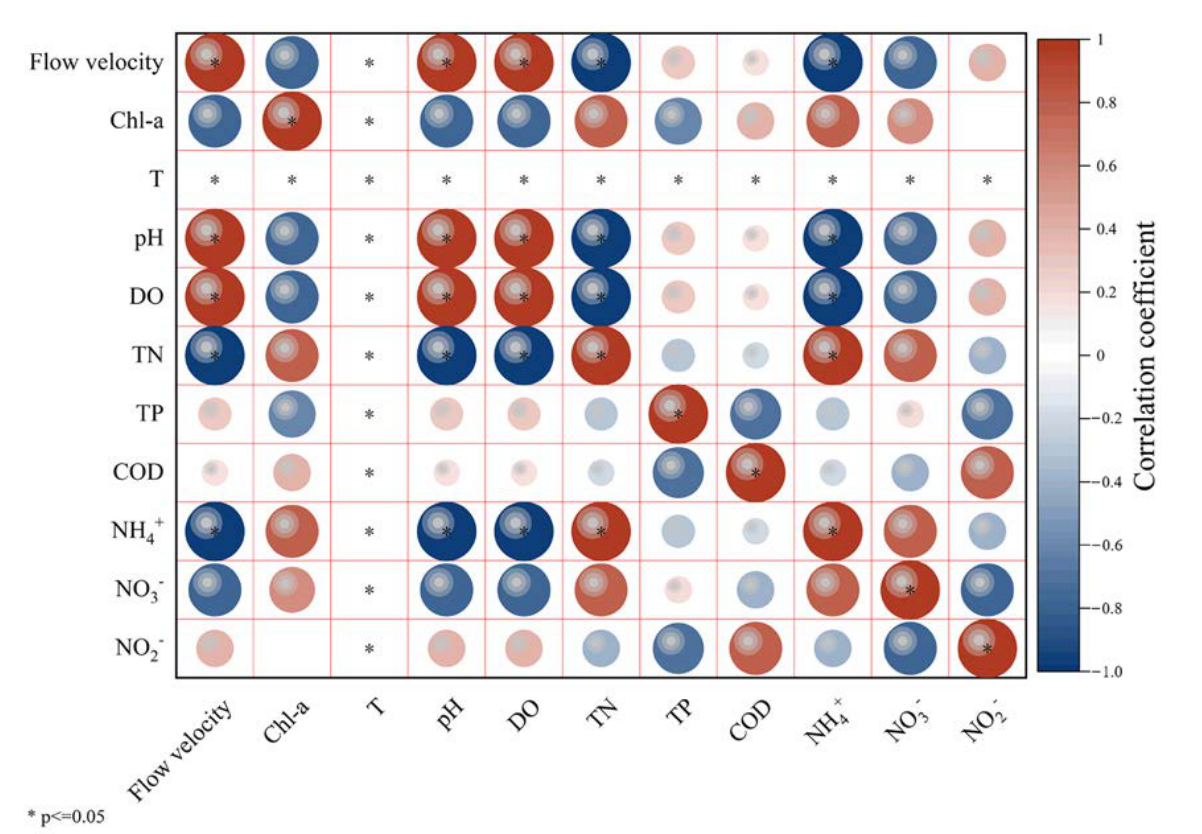
Figure 3. Spearman correlation heat map of environmental factors and benthic algae biomass (* indicates two indicators are significantly correlated, p ≤ 0.05. The larger the circle, the stronger the correlation between the two indicators).